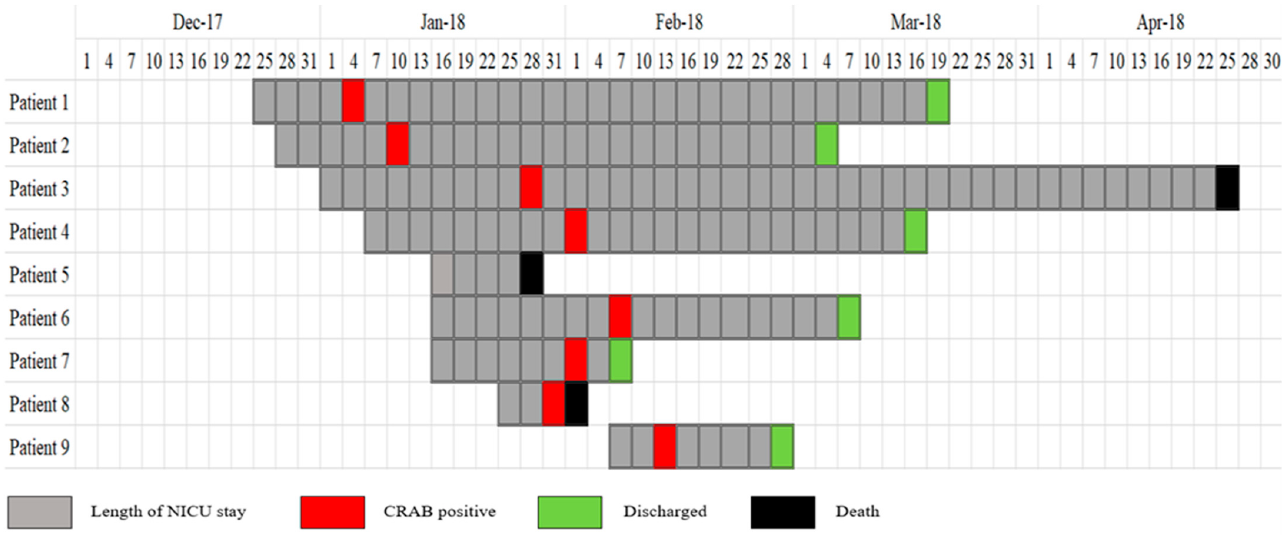
Figure 2. Temporal relationship between 9 infants with carbapenem-resistant Acinetobacter baumannii colonization or infection identified throughout the outbreak. Table 2. Isolation of A. baumannii from various environmental